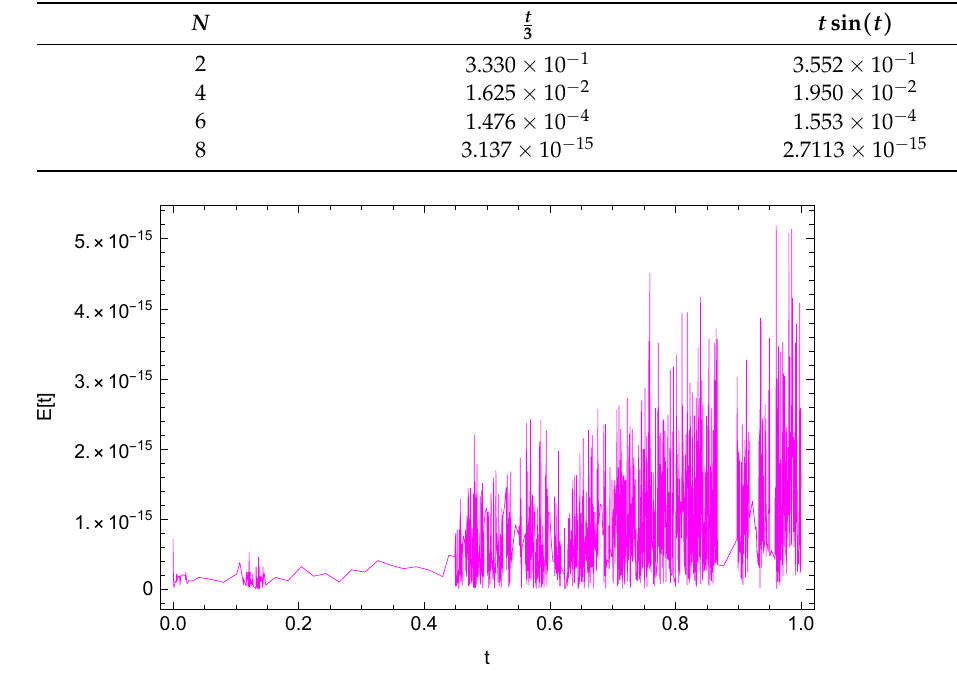
Table 5. The MAE of Example 5 for various values of N , λ = 1 { t , t sin ( t ) }. 3